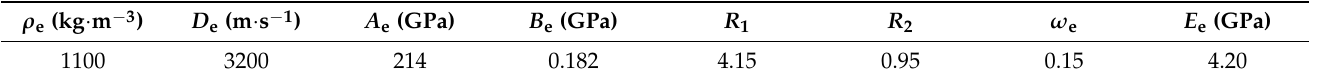
Table 1. Main constitutive parameters of the explosive.